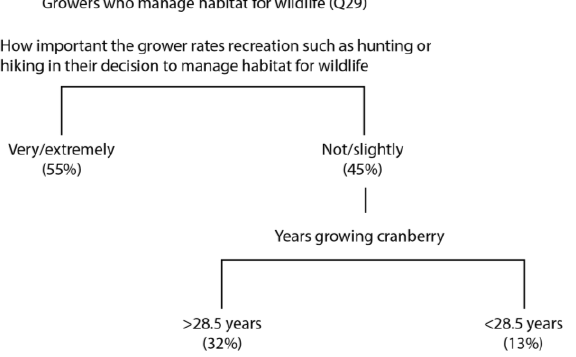
Figure 3. A classification tree that predicts whether growers responded positively to managing habitat for wildlife. Numbers below each tree branch indicate the percent of respondents in that category.